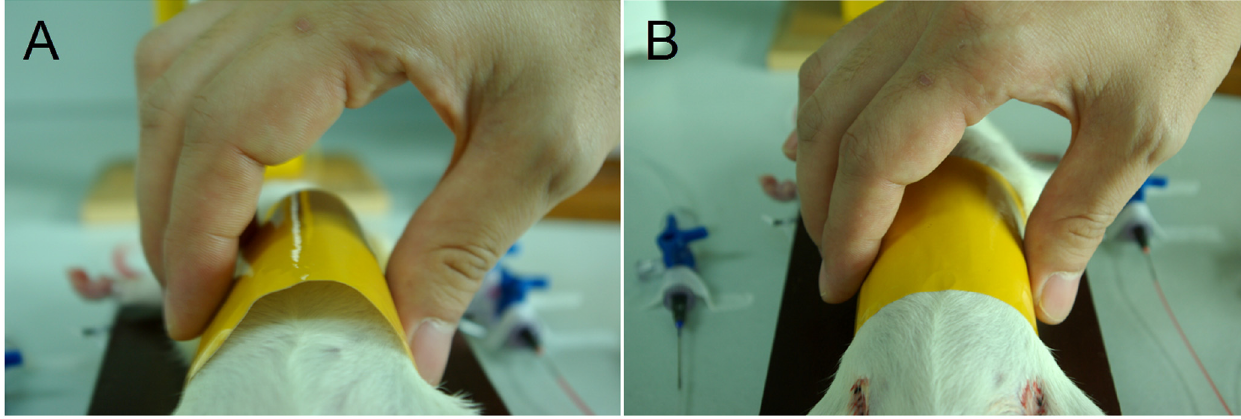
Fig 3. Use of the abdominal restraint device. (A) The abdominal constraint device was applied before resuscitation, ensuring a suitable abdominal compartment to contain hydropic organs and leaked fluid in a certain period of time.(B) After a period of resuscitation the device limits the expansion of the